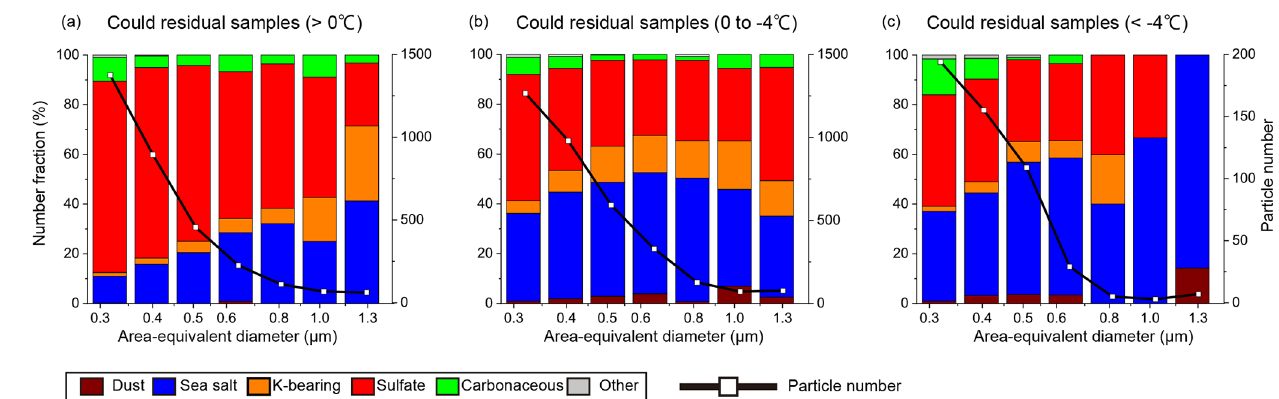
Figure 10. Size-dependent number fractions and number distributions for cloud residual samples collected at (a) > 0 ◦ C, (b) 0 to − 4 ◦ C, and (c) < − 4 ◦ C. N = (a) 3193, (b) 3443, and (c) 502.